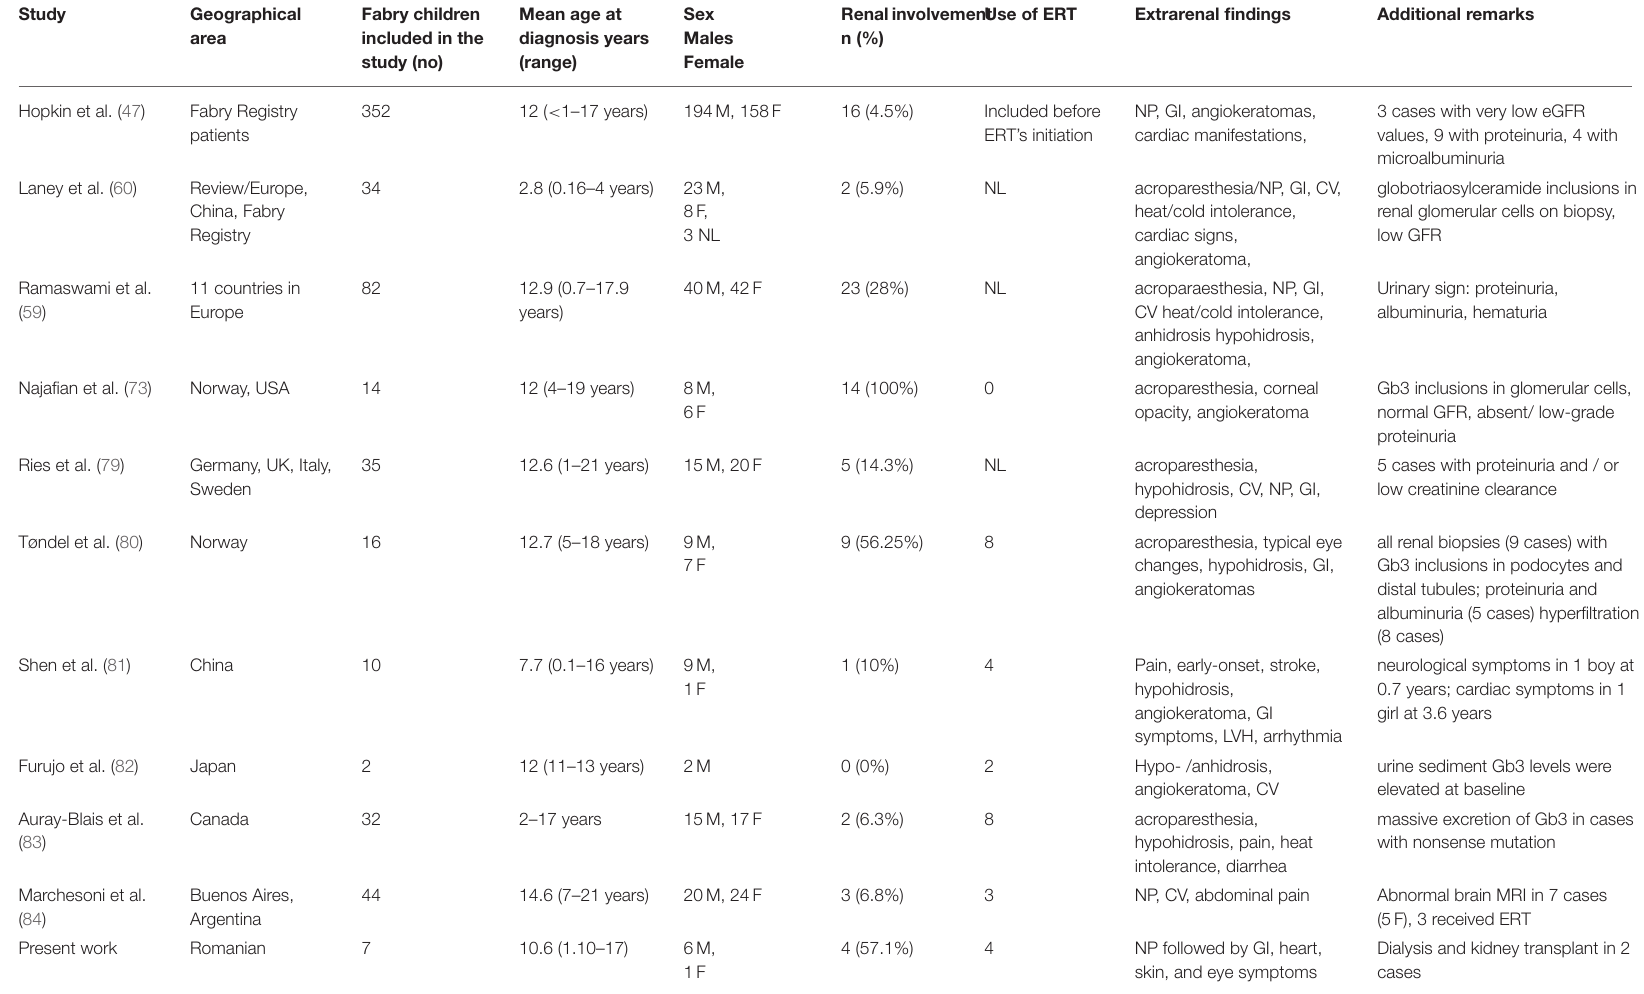
TABLE 4 | Renal involvement in children and adolescents with Fabry disease in different